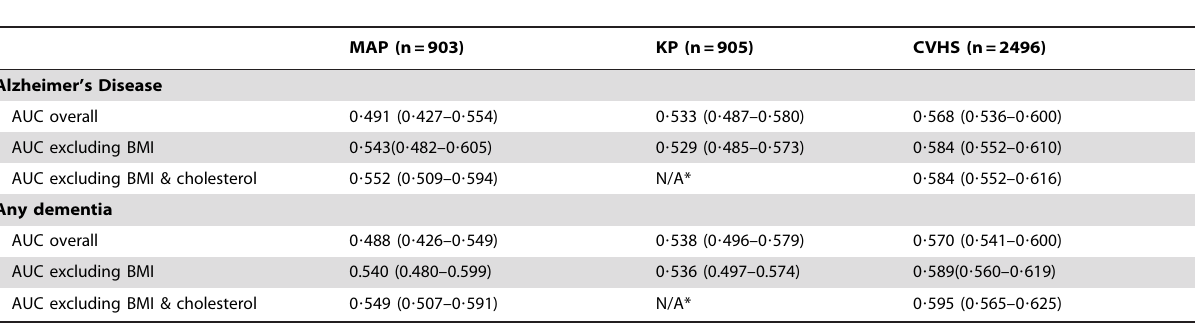
Table 6. Characteristics and accuracy of CAIDE for predicting AD and dementia in the three cohort